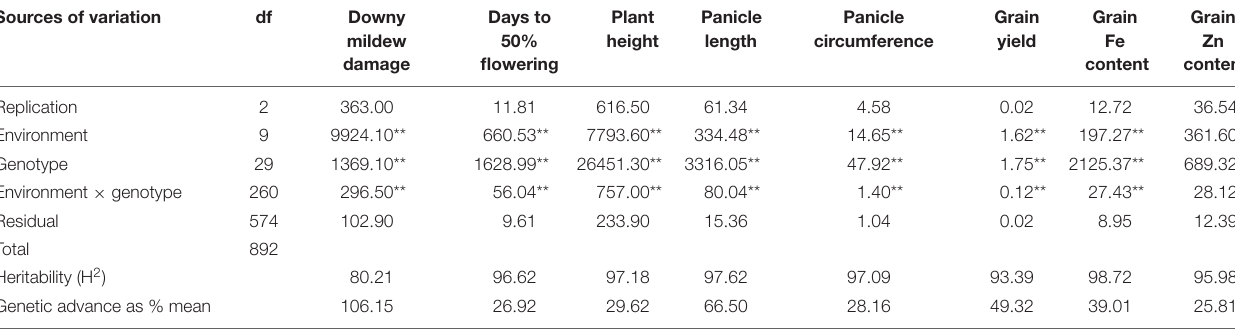
TABLE 1 | Mean sum of squares of pearl millet genotypes across locations in West Africa. Sources of variation